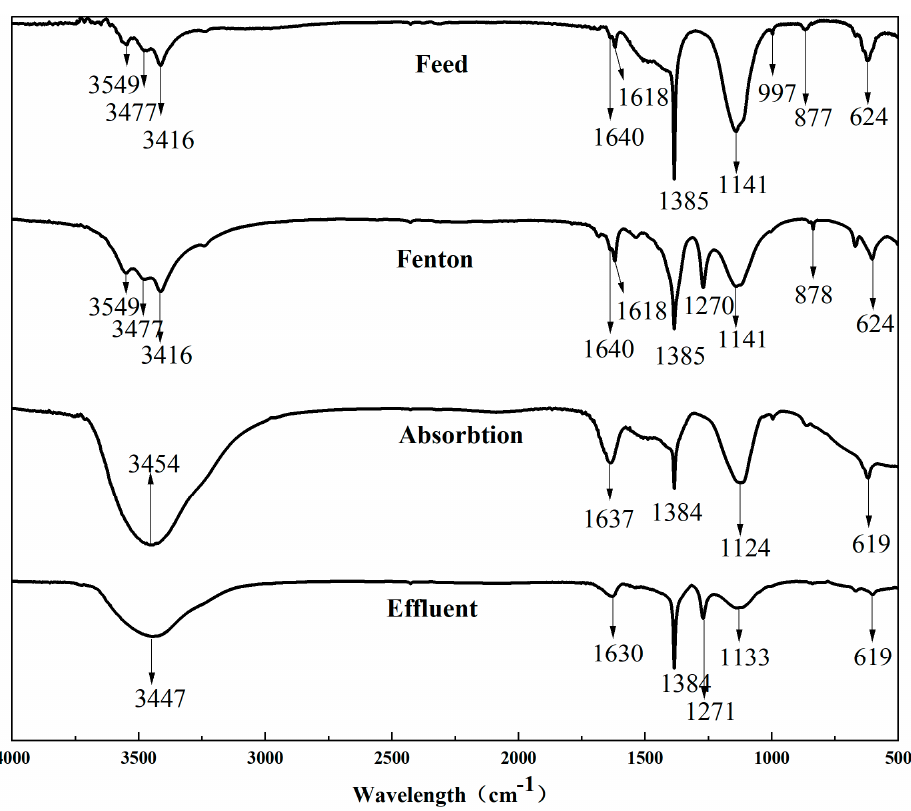
Figure 5. The changes in FTIR for varied effluents: the resolution was 4 cm − 1 , the number of scans was 32 and the scanning interval was 4000–550 cm − 1 .